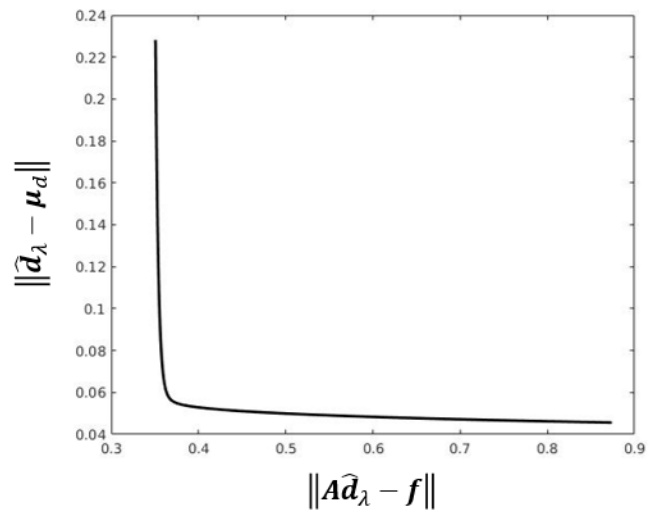
Figure 2. An example of the L-curve